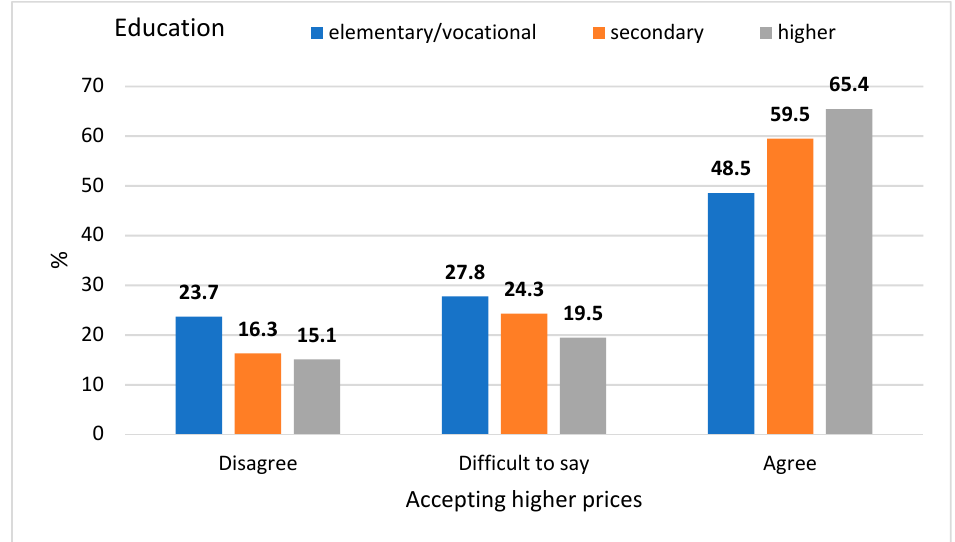
Figure 2. Percentage frequency distribution of accepting higher prices for products that do not cause environmental harm according to respondents’ education.